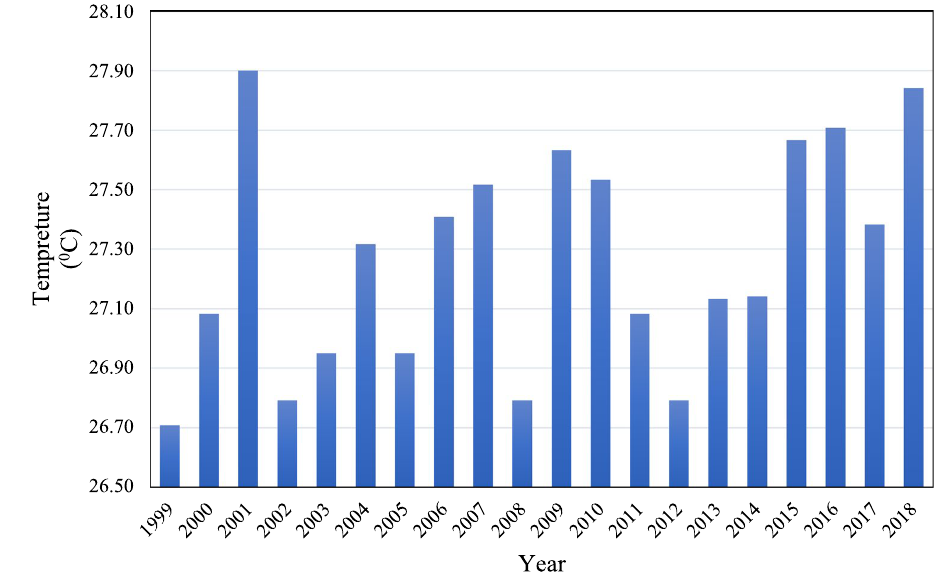
Fig. 5 Mean annual temperature